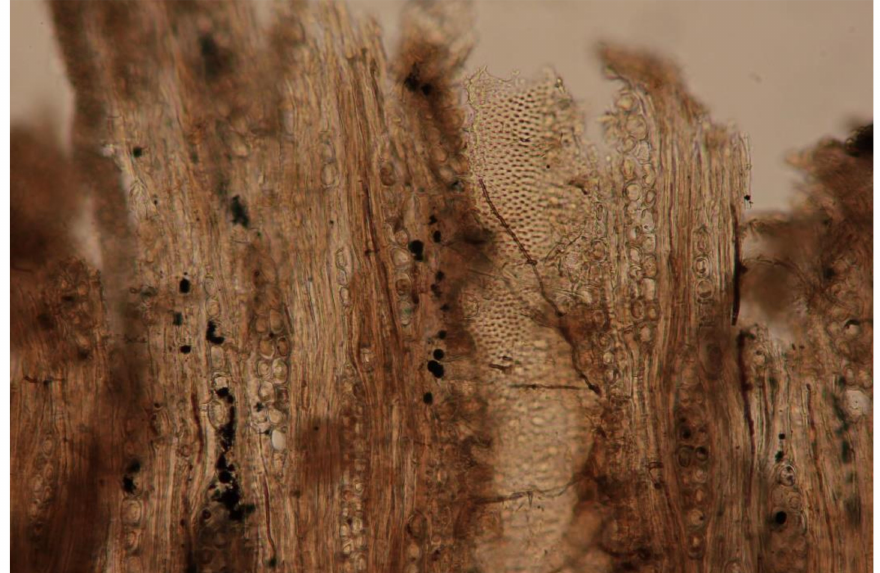
Figure 6. Light microscope image of a tangential-longitudinal section of a Pistacia spp. wood (100 × ). Intervessel pits alternate. The waterlogged wood sample derives from an underwa- ter excavation site at the mouth of Ropotamo River located along the Bulgarian coast [34]. Image: A. Zisi, © Black Sea